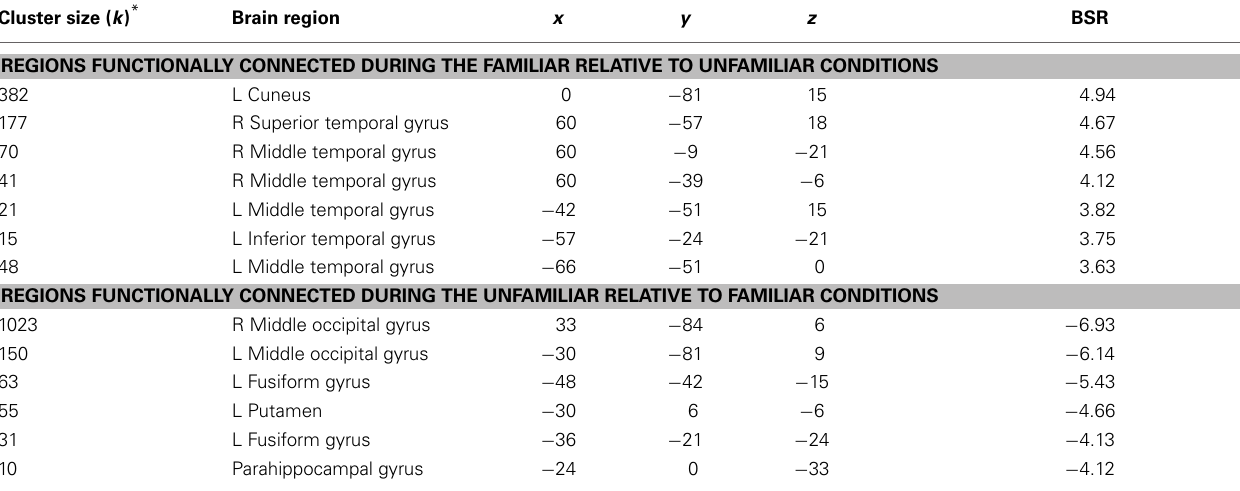
Table 4 | Regions showing significant functional connectivity with the right anterior hippocampal seed. Cluster size ( k ) * Brain region x y